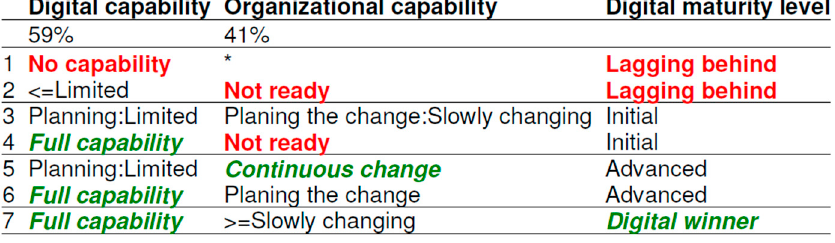
Figure 3. Defining the utility function— “ if–then ” rules.